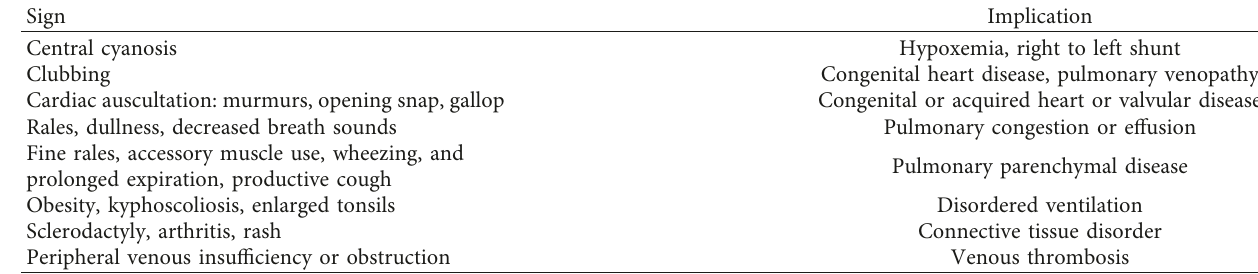
Table 2: Physical exam findings of pulmonary